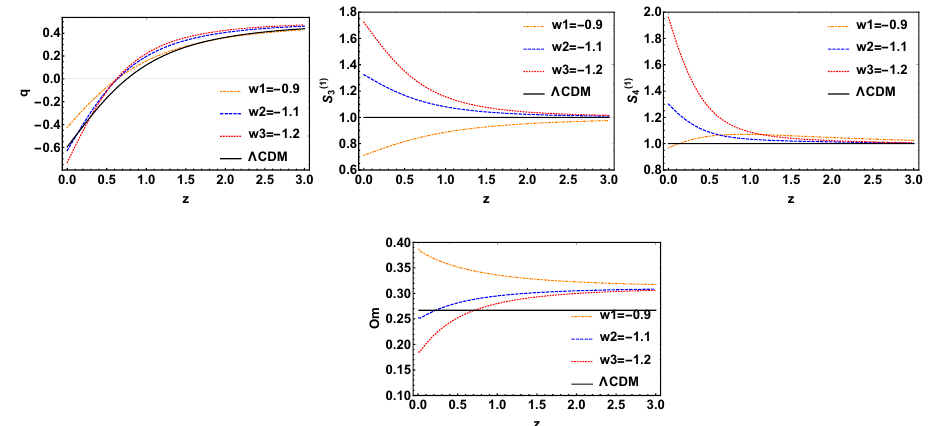
( 1 ) ( 1 ) , S and Om , respectively, versus red shift z for the 3 4